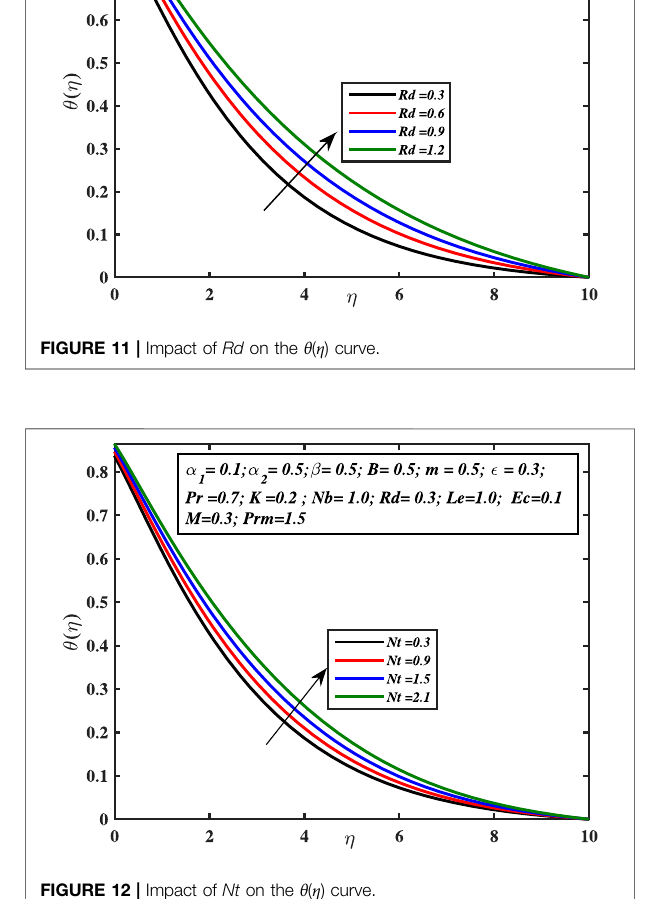
FIGURE 12 | Impact of Nt on the θ ( η ) curve.